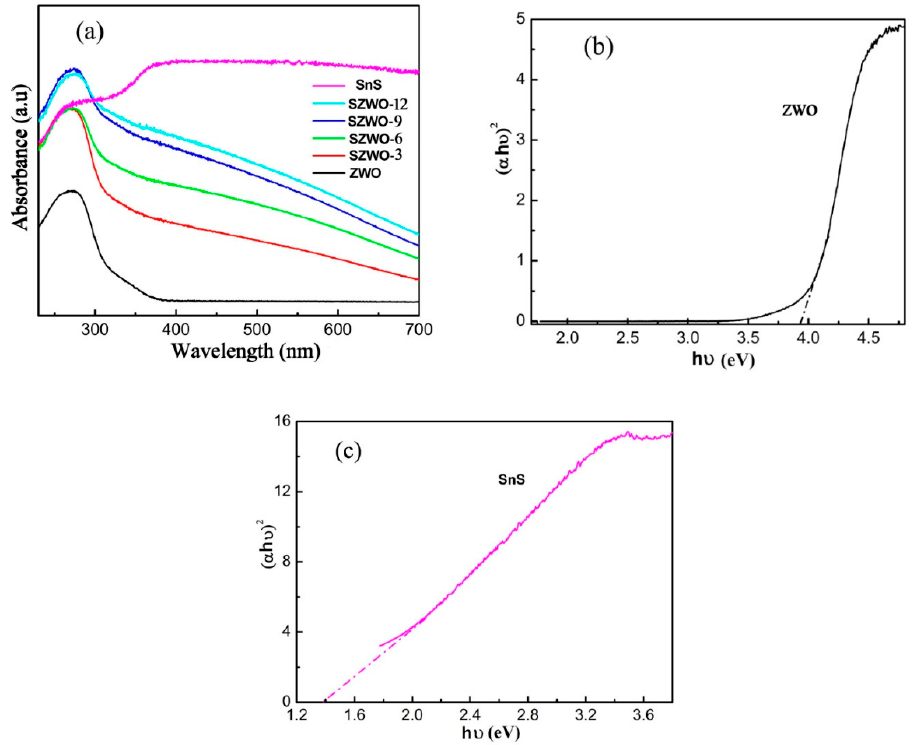
Figure 6. ( a ) UV–vis absorbance spectra of ZWO, SnS and SnS/ZWO hybrid composites, ( b ) the derived plot of ( α hv ) 2 versus hv from the absorption spectrum for ZWO; ( c ) the derived plot of ( α hv ) 2 versus hv from the absorption spectrum for SnS sample